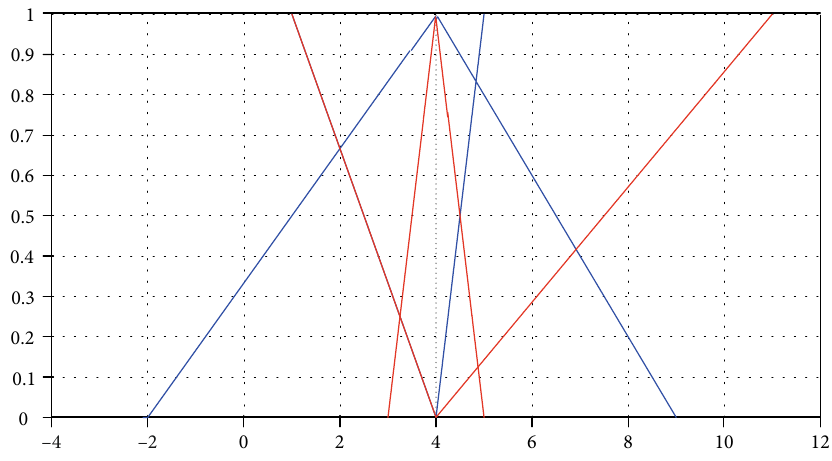
Figure 4: The graph of the solution obtained in Example